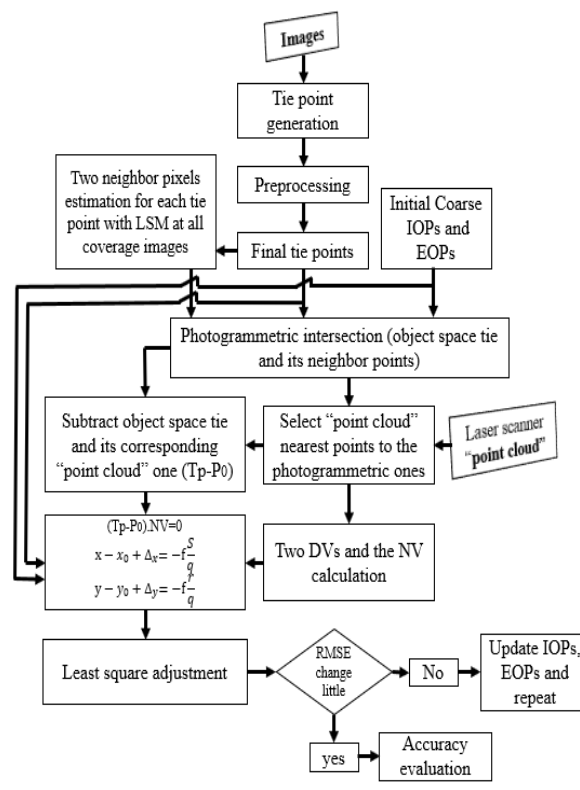
Figure 1. Flowchart of the proposed method